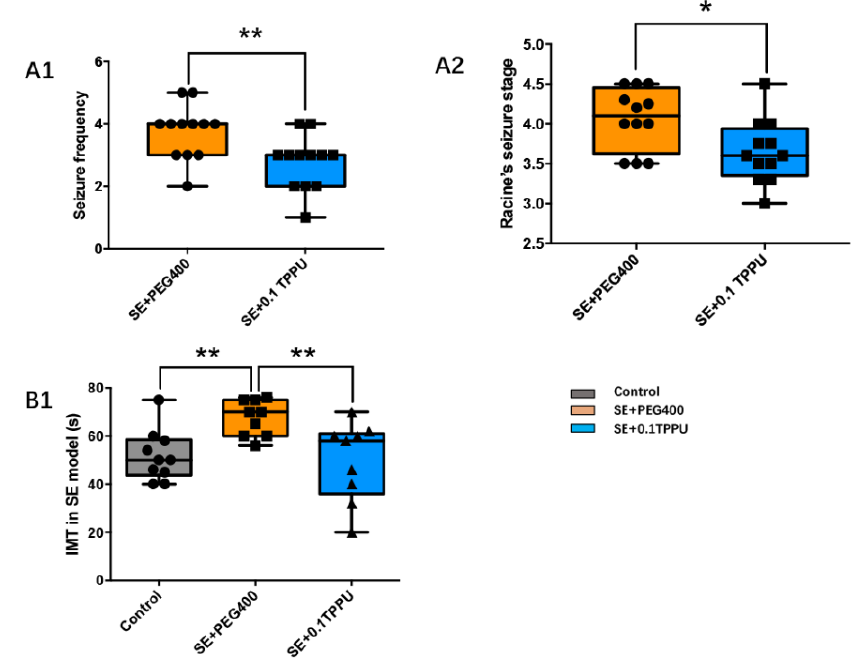
Figure 2. The seizure frequency ( A1 ) and Racine’s seizure grade ( A2 ) during status epilepticus were decreased significantly in the SE+0.1TPPU group compared with SE+PEG400 group. ( B ) The immobility time (IMT) was significantly increased in the SE+PEG400 group compared with the Control group, which was significantly decreased after TPPU treatment in the SE+0.1TPPU group compared with the SE+PEG400 group. (Figure 2A1, student t -test, Figure 2A,B, one-way ANOVA test, * p < 0.05, ** p < 0.01, n = 12). SE, status epilepticus; IMT, the immobility time.